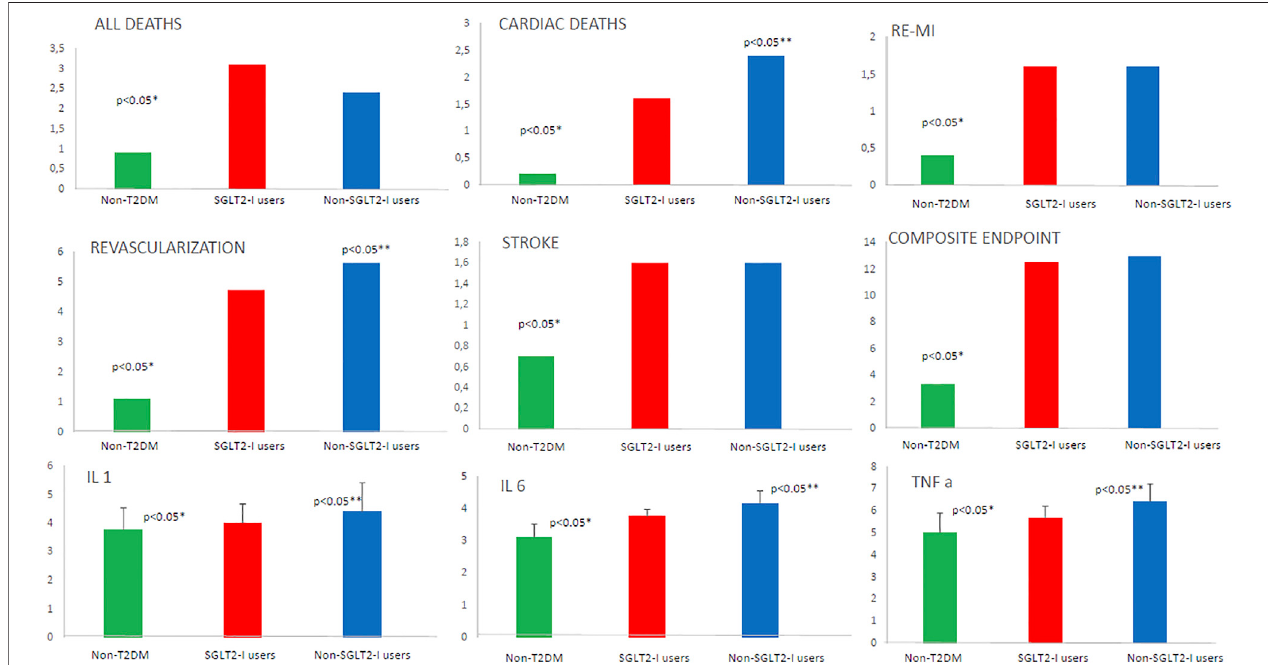
FIGURE 1 | The representation of the study outcomes at 1 year of follow-up in patients without type 2 diabetes mellitus (non-T2DM; green color) vs T2DM under sodium-glucose transporter 2 inhibitors (SLGT2-I users; red color) vs T2DM patients without sodium-glucose transporter 2 inhibitors (non-SLGT2-I users; blue color). We reportedthepercentage ofeventsforalldeaths,cardiac deaths,re-myocardialinfarction(re-MI),stroke, revascularization,andcomposite endpoint.Forinterleukin 1 (IL-1),interleukin6(IL-6),andtumor necrosisfactor-alpha (TNF- α ),weusedthevaluesasmean ± standarddeviation.*Isforstatisticalsigni fi cant( p -value < 0.05) vs T2DM; ** is for statistical signi fi cant ( p value < 0.05) comparing SGLT2-I users vs non-SLGT2-I users.